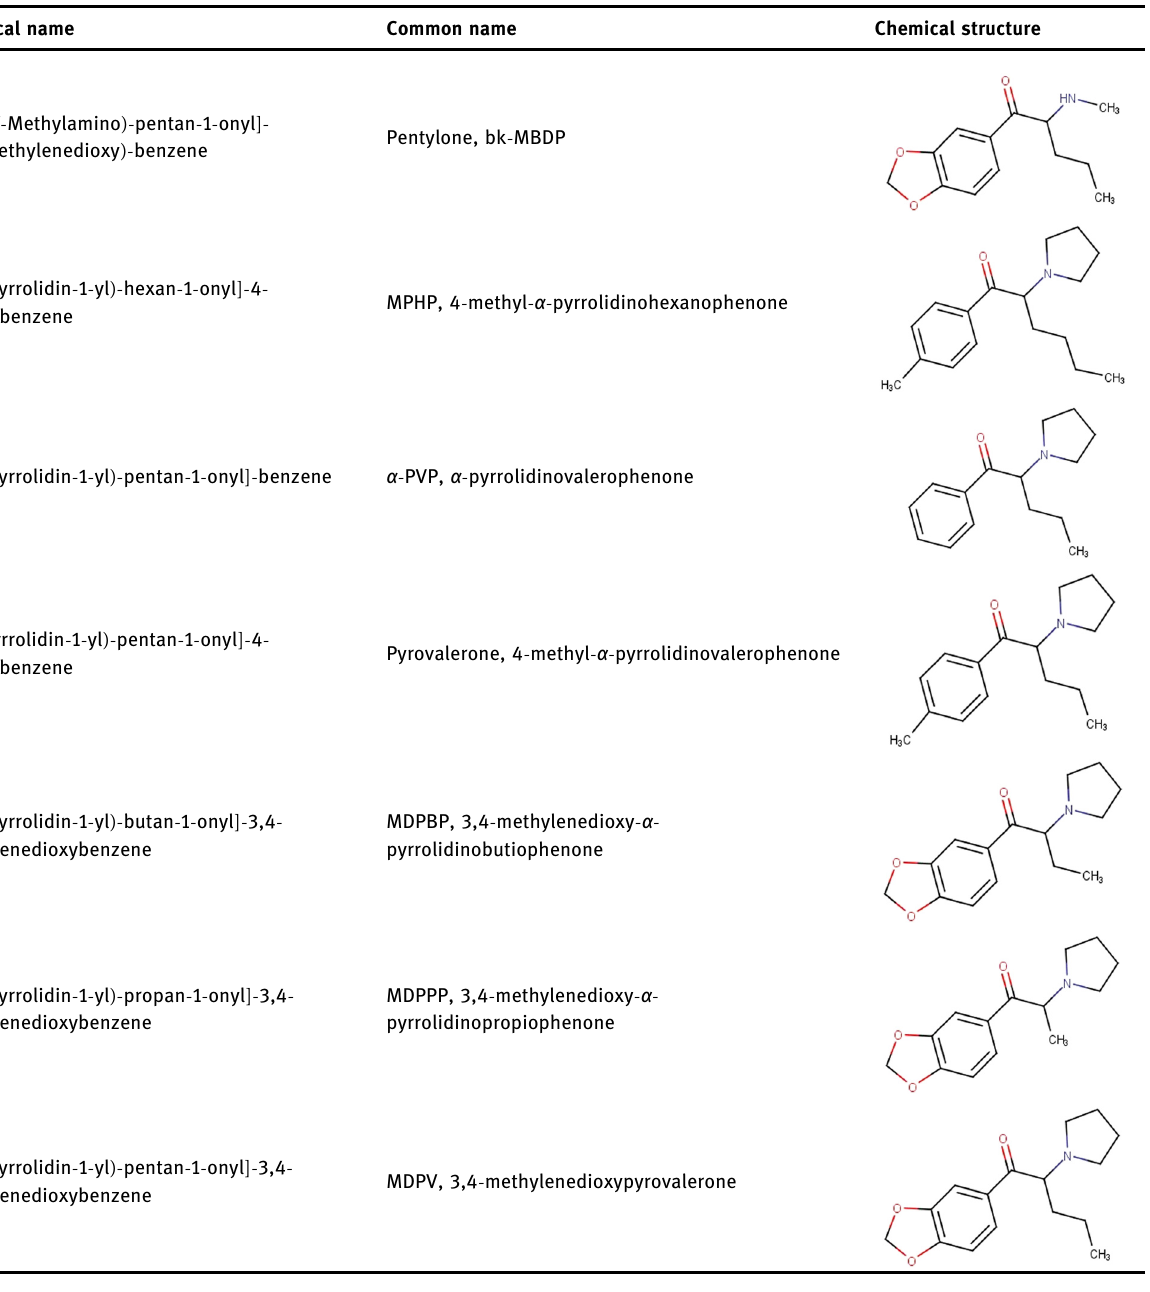
natremia, hyperkalemia, acute renal failure, hyperuri - cemia; musculoskeletal system: elevated creatinine kinase, peripheral vasoconstriction, rhabdomyolysis; ophthalmic system: mydriasis, nystagmus, blurred vision; ENT: epistaxis, tongue disorder, oral and pharyngeal e ff ects, bruxism, trismus; consequences of IV use: vein blockage, localinfection,skinerosion,scab,lump,abscess,gangrenous